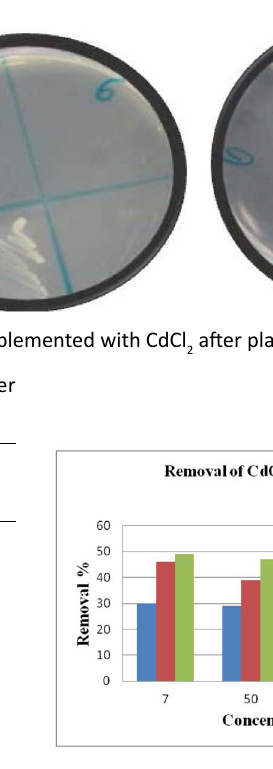
Fig. 14. Cadmium removal by Bacillus cereus ST.